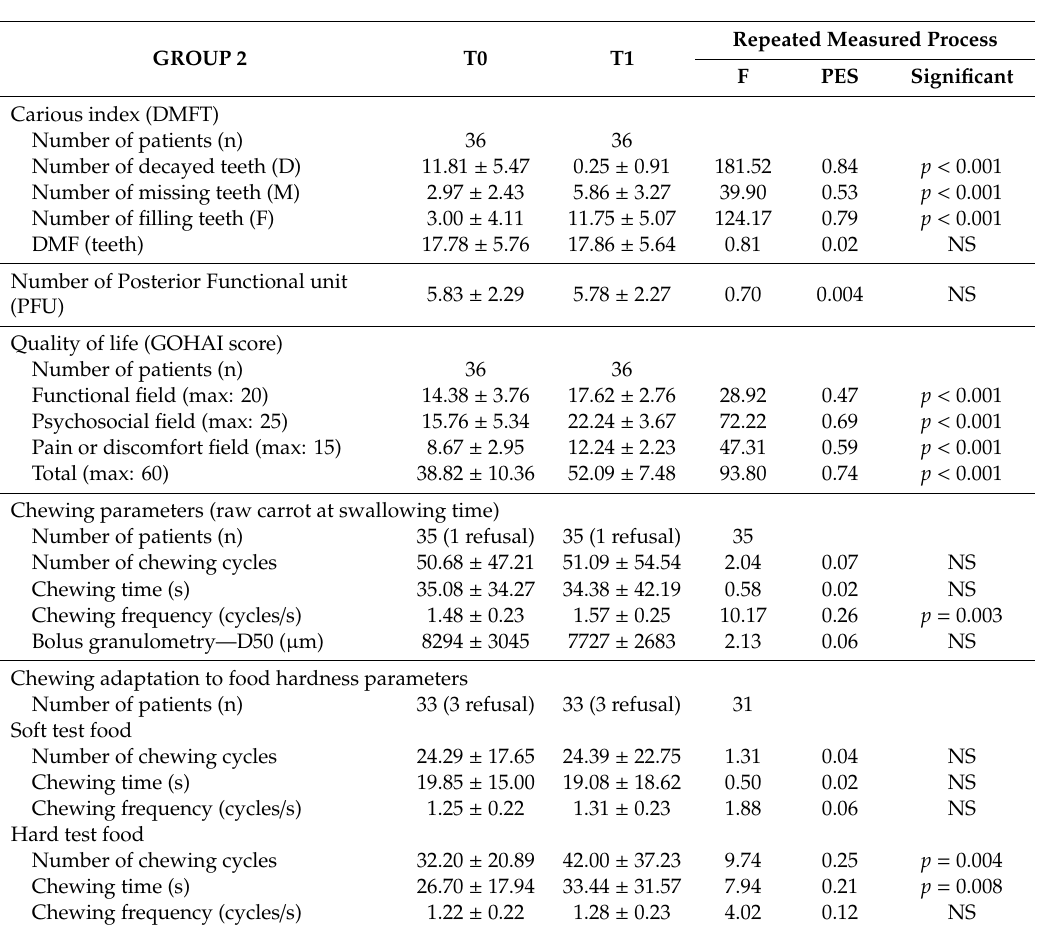
Table 4. Comparisons of study criteria values for the group of patients evaluated before treatment under GA (T0) and one month after treatment (T1) (repeated measures ANOVA with post hoc Bonferroni correction). GROUP 2 T0